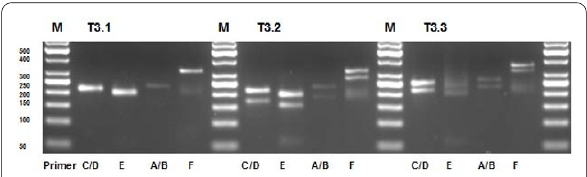
Figure 3 3% gelelectrophoresis of the PCR products amplified from the third-trial samples . Amplifications were performed with four different primer pairs in Lab D. The amplification was done using an annealing temperature of 60°C for each primer set. M: DNA length standard Gene Ruler 50 bp (Fermentas, St. Leon-Roth,